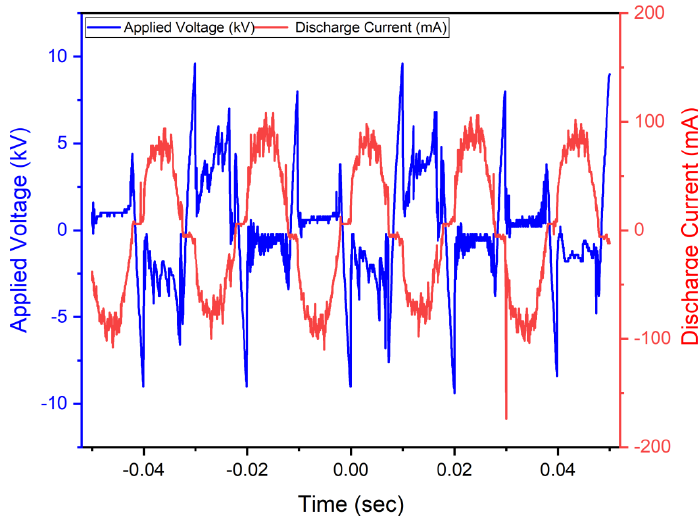
Figure 3. Current [I(t)] and voltage [V(t)] waveform of the generated discharge.